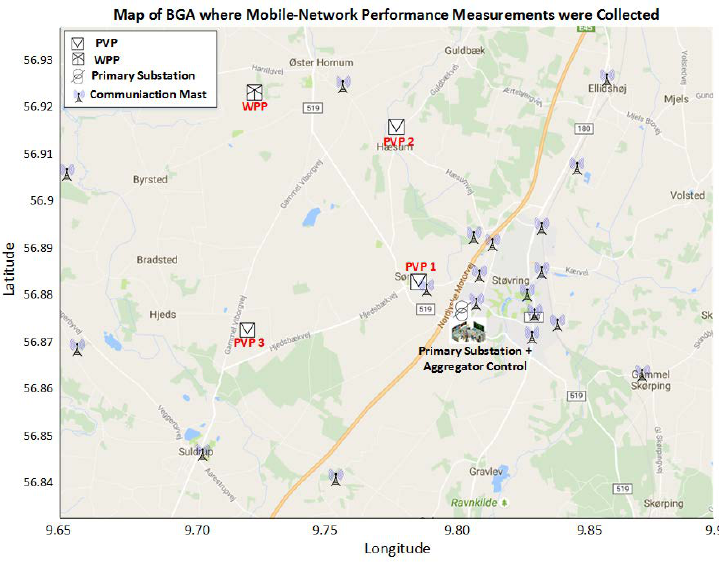
Figure 7. Map of BGA showing the locations of all ReGen plants in BDG and communication masts surrounding the area.